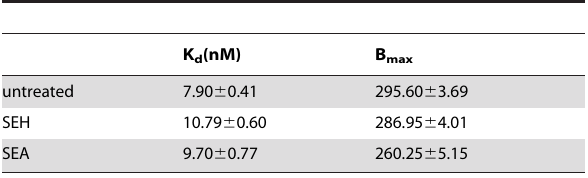
Table 1. Presence of SEA or SEH does not significantly alter the affinity of the anti HLA-DR1 probe